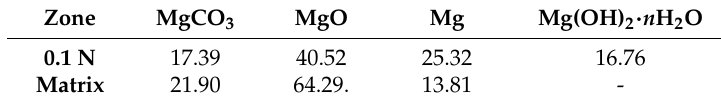
Table 4. Ratio of surface compositions before and after sliding friction (%).